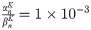
Bistability in the stochastic domain.The original tristable system is simulated in a system of 300 substrate molecules (with sequestration strengths of αnKβnK=1×10-3
nM−1 and α0Pβ0P=1×10-3
nM−1), corresponding to the original system in a volume of 4.98 × 10−17 L. Bistability in the deterministic domain (left) manifests itself as bimodality in the stochastic domain (right). The simulation was done using the Gillispie Stochastic Simulation Algorithm (SSA).